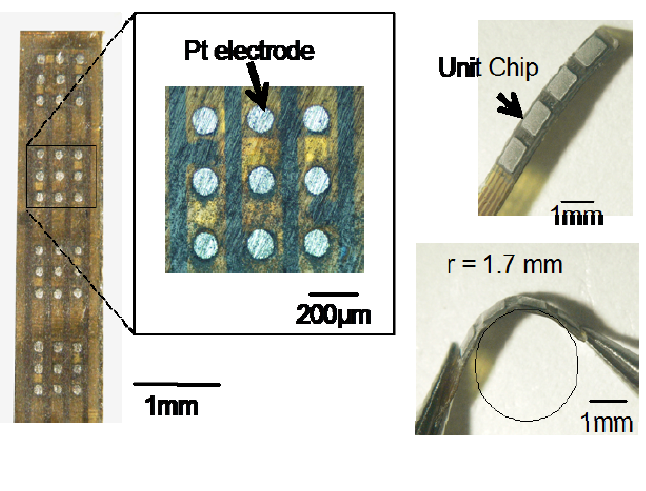
Figure 12. Fabricated retinal stimulator based on the multiple microchip architecture (adapted from [5]).